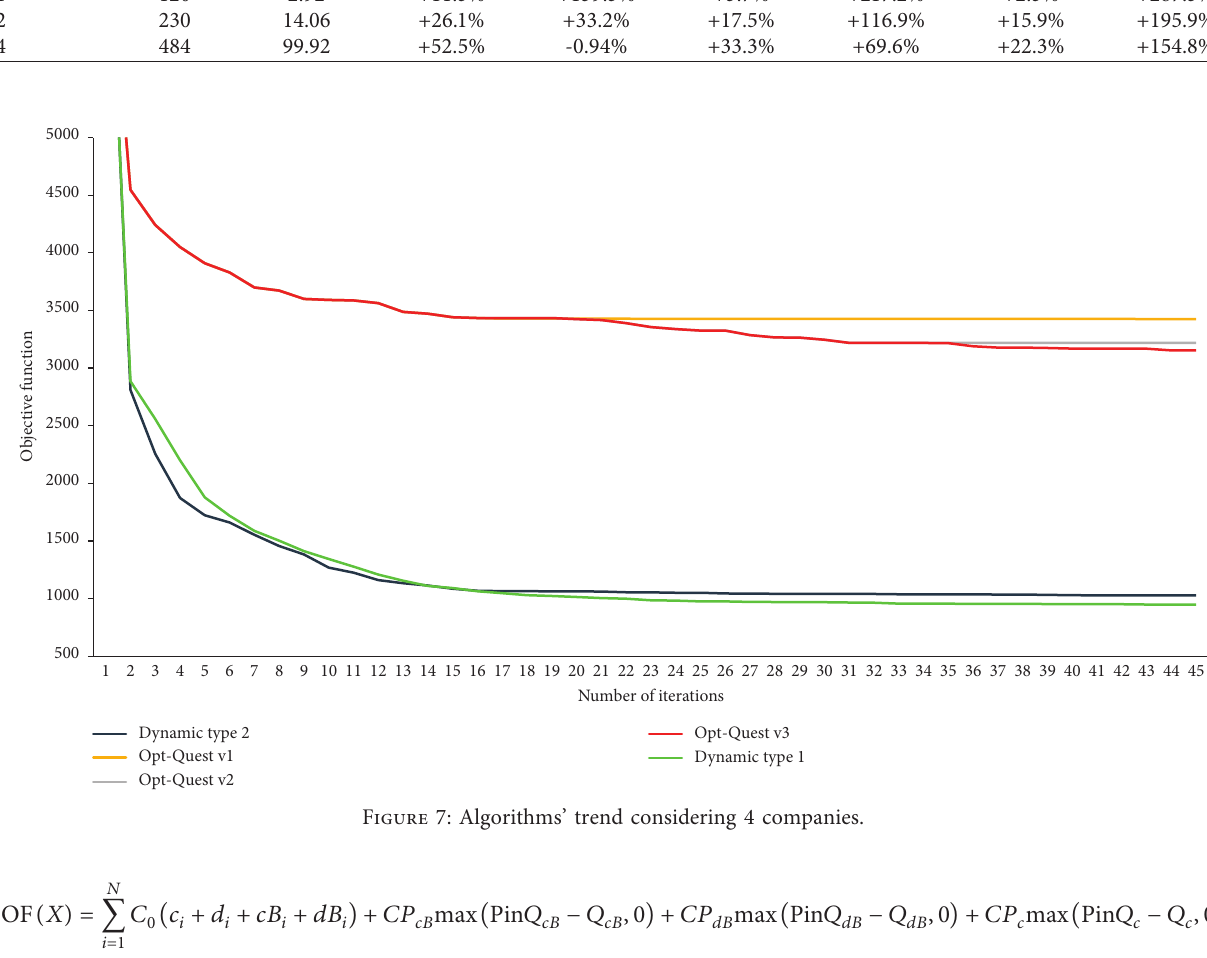
Figure 7: Algorithms’ trend considering 4 companies.